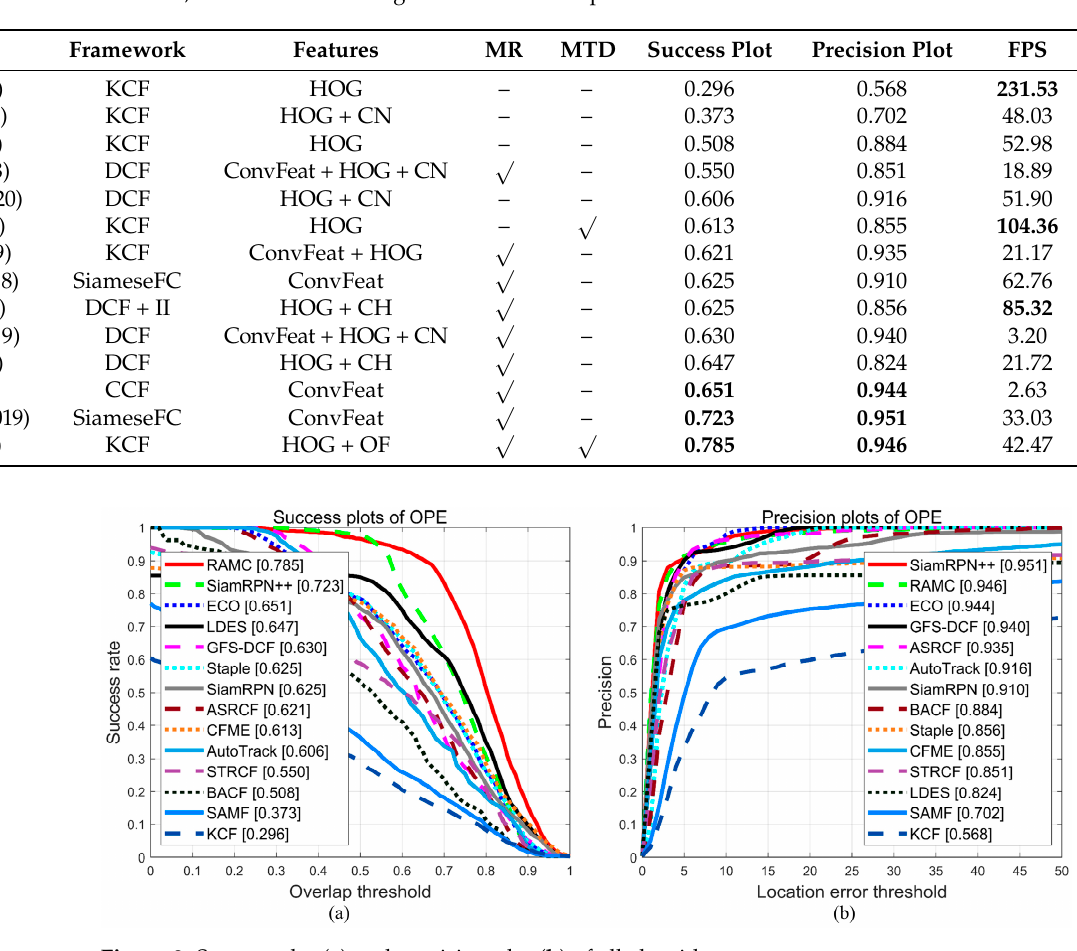
Figure 9. Success plot ( a ) and precision plot ( b ) of all algorithms.